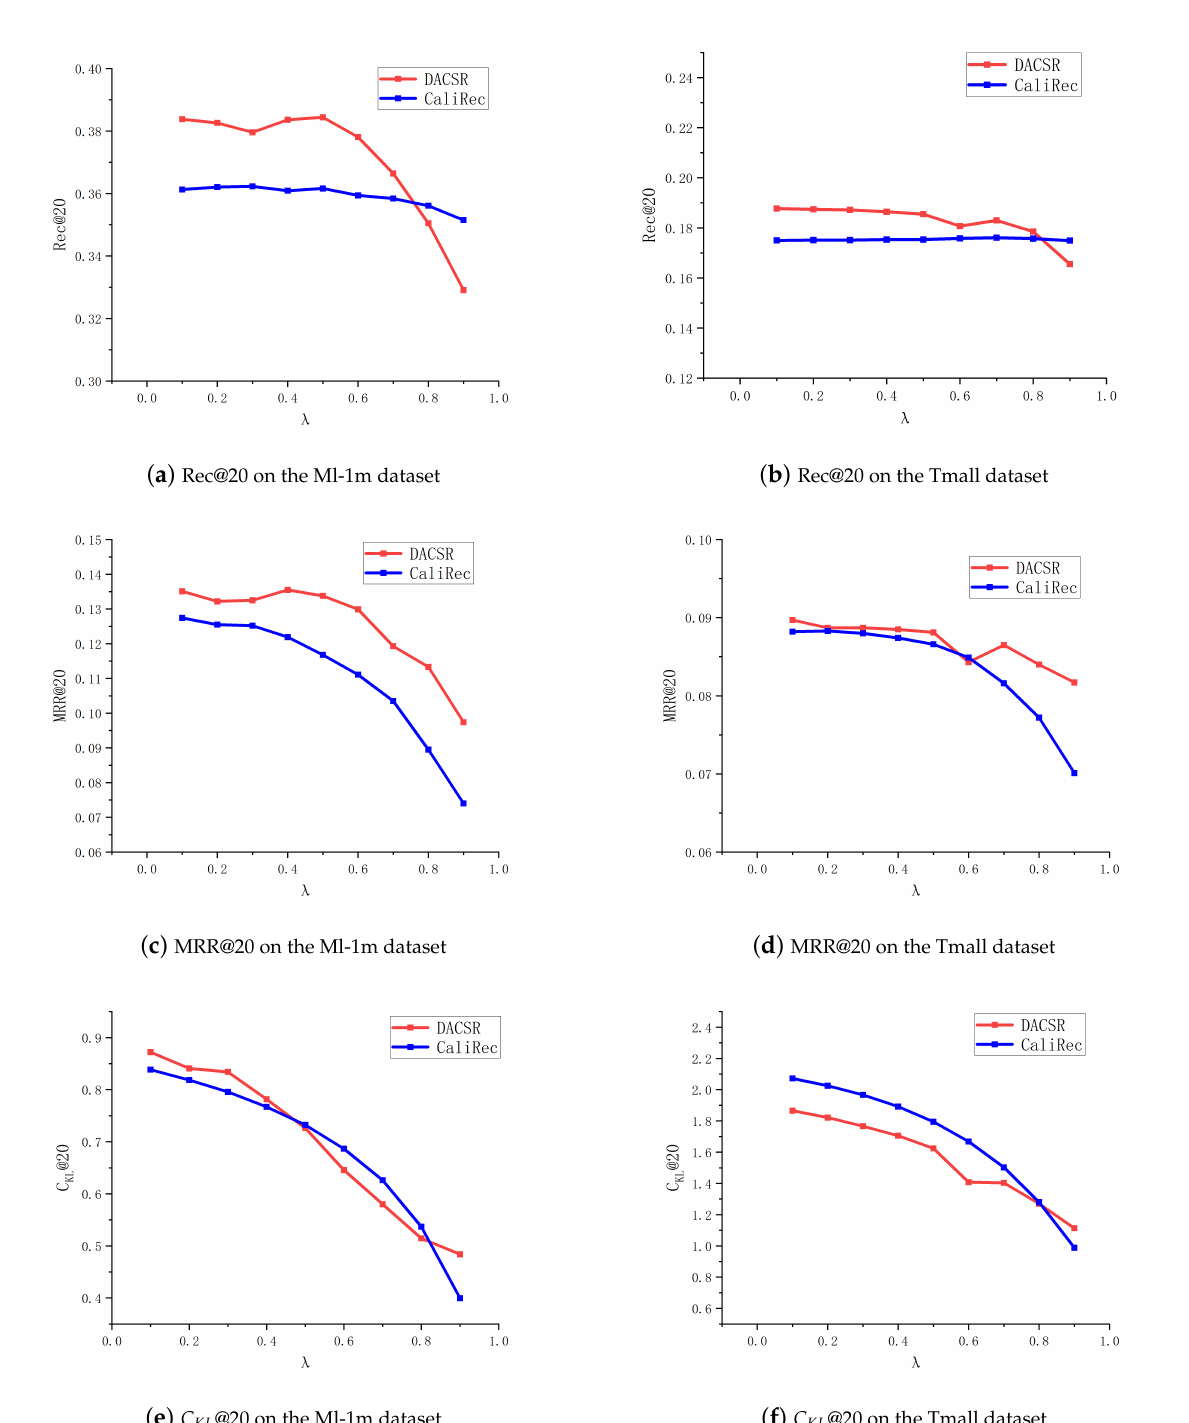
Figure 3. Performance comparison when λ